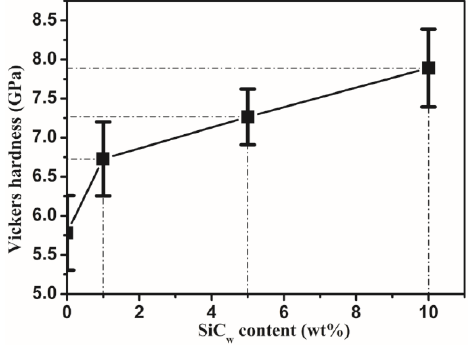
Fig. 10 Variation of Vickers hardness in the SiC w /Ti 3 SiC 2 as a function of SiC w content.